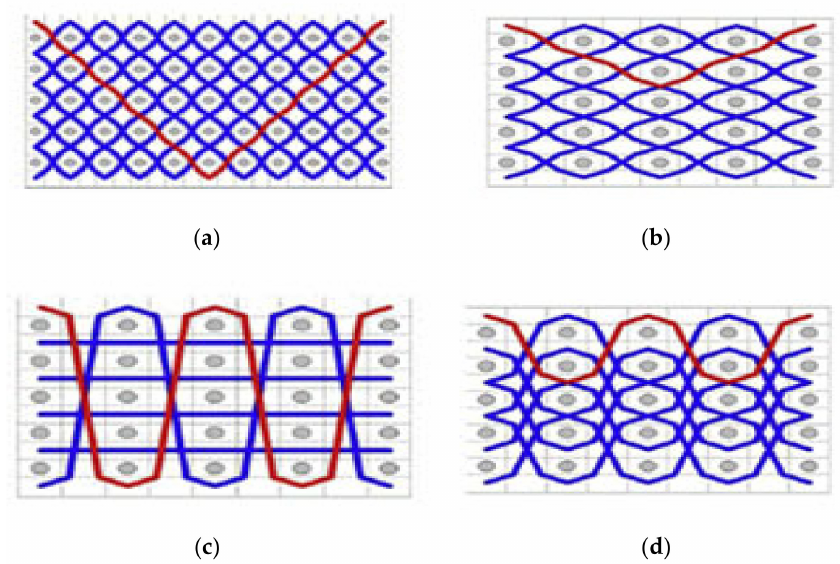
Figure 1. Representation of the four classes of 3D warp interlock fabrics types ( a ) interlock A-T, ( b )‘interlock A-L, ( c ) interlock O-T, and ( d ) interlock O-L [26]. (Reproduced with permission from Elsevier with License Number